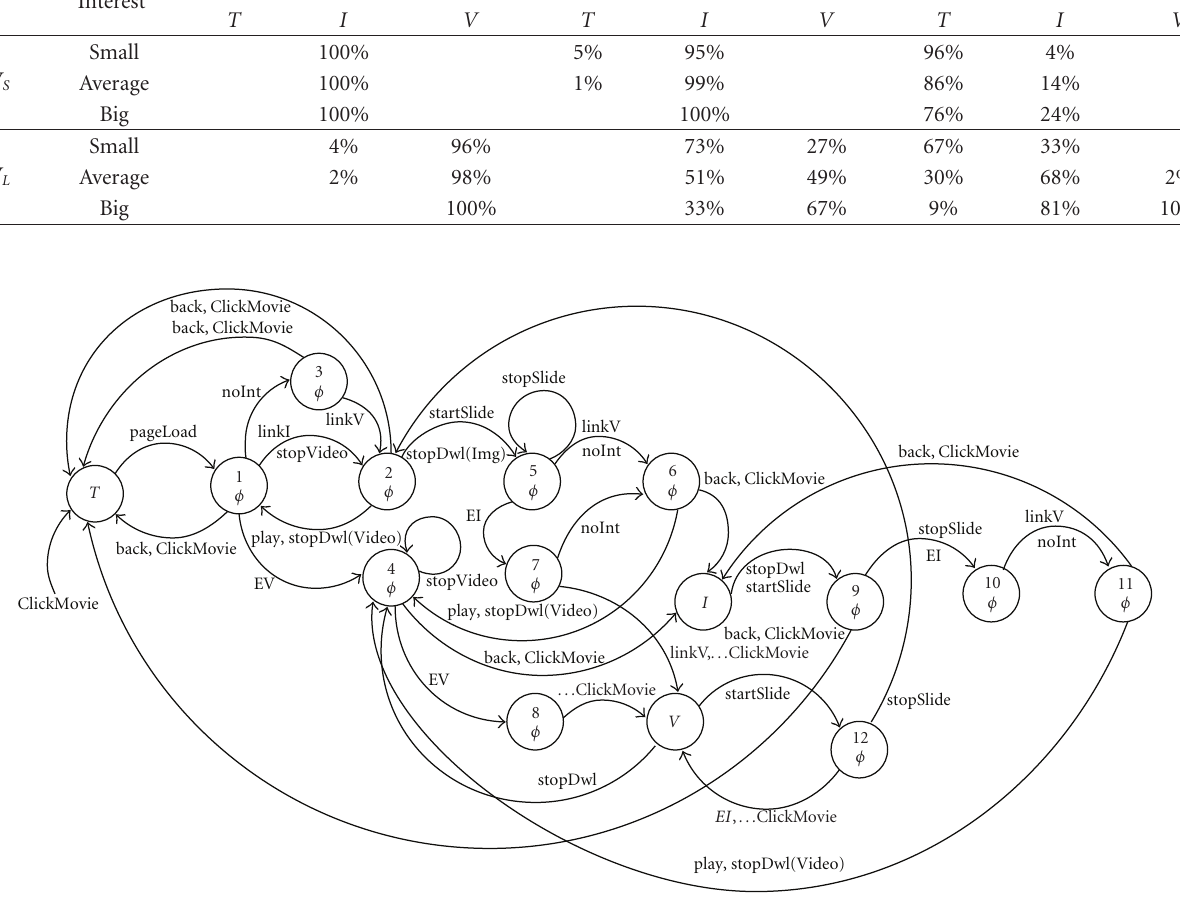
Figure 9: Decision-making automaton (policy graph), POMDP solution. Please note the di ff erent stopDwl , stopDwl(Img) , and stopDwl(Video)